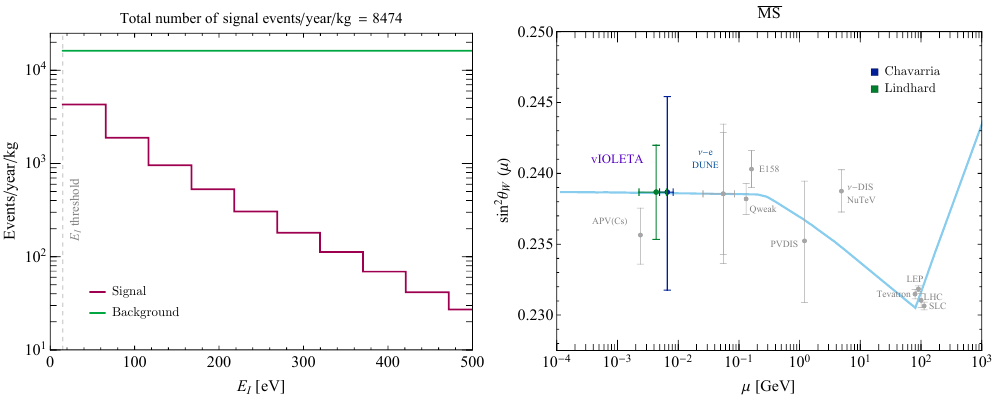
Figure 2 . Left: spectral rate of signal (red histogram) and background (green) events for our benchmark setup (see table 2). The vertical dashed line shows the ionization energy threshold of Skipper CCDs. Right: sensitivity of our experimental setup to sin 2 θ W compared with different experiments (Atomic Parity Violation (APV) [95], Qweak [96], E156 [97], Parity Violation in Deep Inelastic Scattering [98], NuTeV [92], LEP [99], SLC [100], Tevatron [101], LHC [102–104]) in the MS renormalization scheme prediction (light blue line). The DUNE point corresponds to the sensitivity expected measuring neutrino-electron elastic scattering [91]. The two colored data points correspond to two different quenching factors, Lindhard (green) and Chavarria (dark blue). No uncertainty on the quenching was considered. The renormalization scale µ can be conveniently identified as the average momentum transfer µ 2 = h Q 2 i